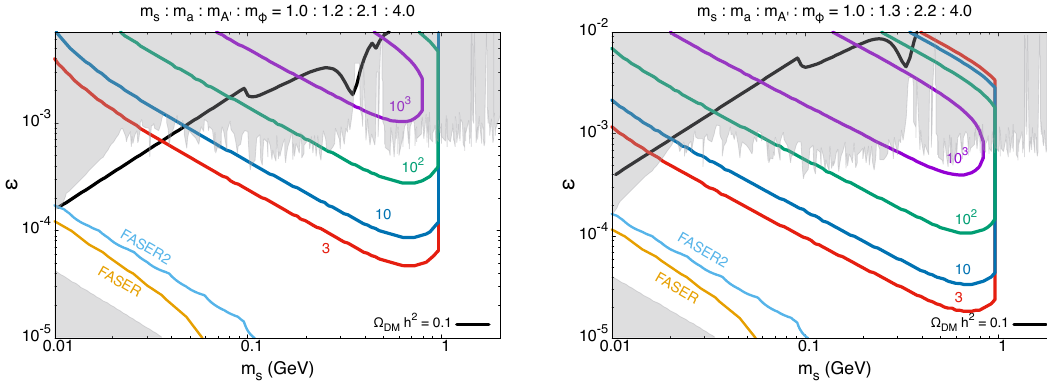
Figure 4 . The same figure for the scalar DM. The gray regions are taken from [26].